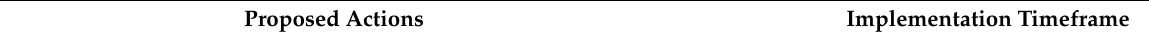
Table 5. Proposed measures for government/public organizations to reduce construction